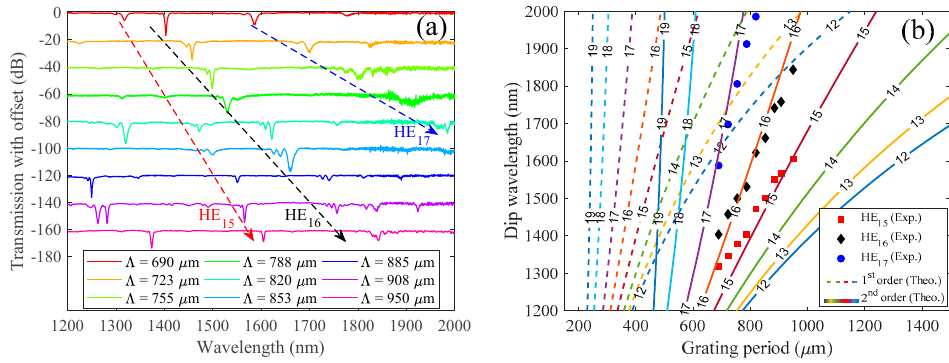
Figure 9. ( a ) Transmission spectra (with offset, tick spacing of 20 dB), acquired for the permanent LPGs inscribed through UV radiation by the amplitude mask technique, using different periods. ( b ) Experimental (marker points) and calculated (curve lines) resonance wavelengths as function of the grating period for the coupling of the fundamental core mode to the first eight cladding modes. The dashed and solid lines correspond to the 1st and 2nd order diffractions, respectively. The numbers in–between each line, define the subscript m, n of the HE mn modes.